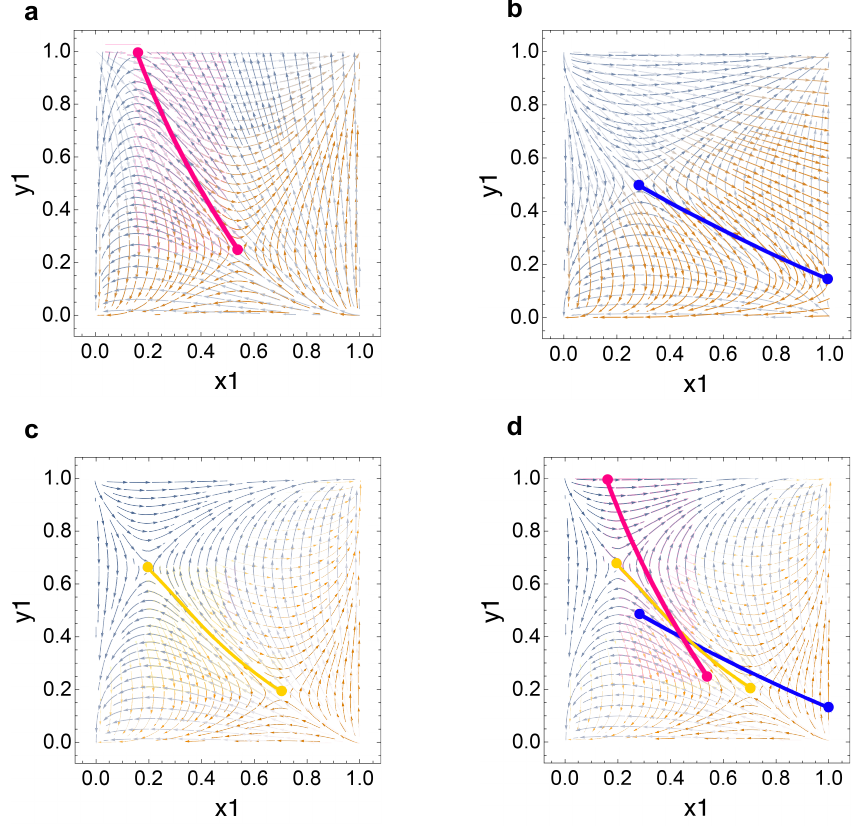
Figure 16. Attractor arc drift transformations. ( a ) Arc transformation with lenient policy matrix operation, see Figure 14; theoretical GameState payoff pair, see Figure 1; and δ a p = 3. ( b ) Arc transformation with strict policy matrix operation, see Figure 15; theoretical GameState payoff pair, see Figure 1; and δ a p = 3. ( c ) Reference attractor arc with theoretical GameState payoff pair, see Figure 1. ( d ) Composite diagram with arcs ( a – c